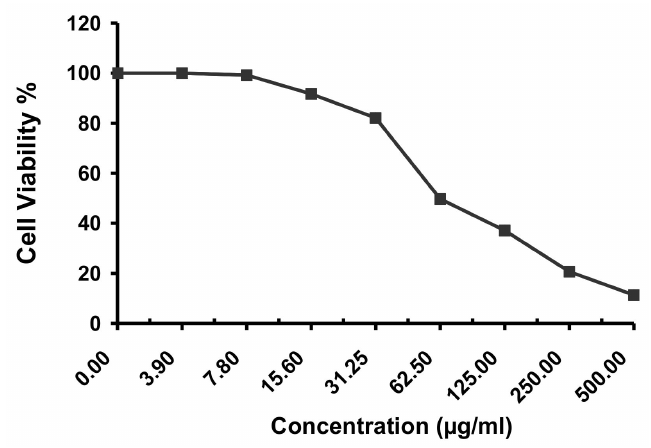
Figure 11. MCF-7 of dye 30h .